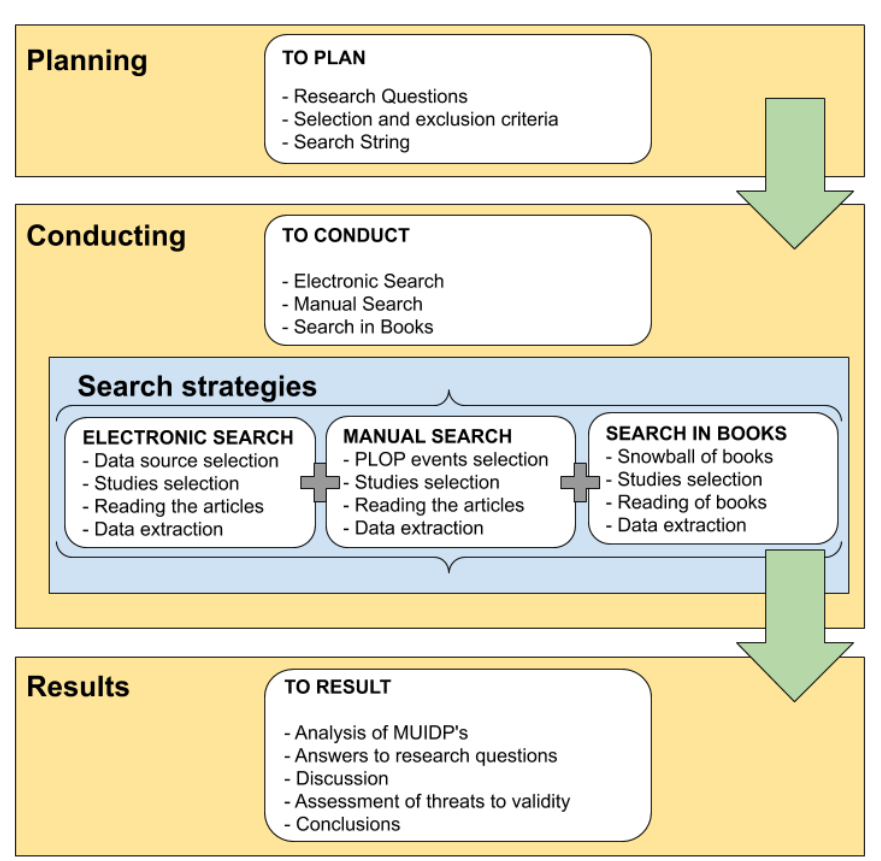
Figure 1. Stages of systematic